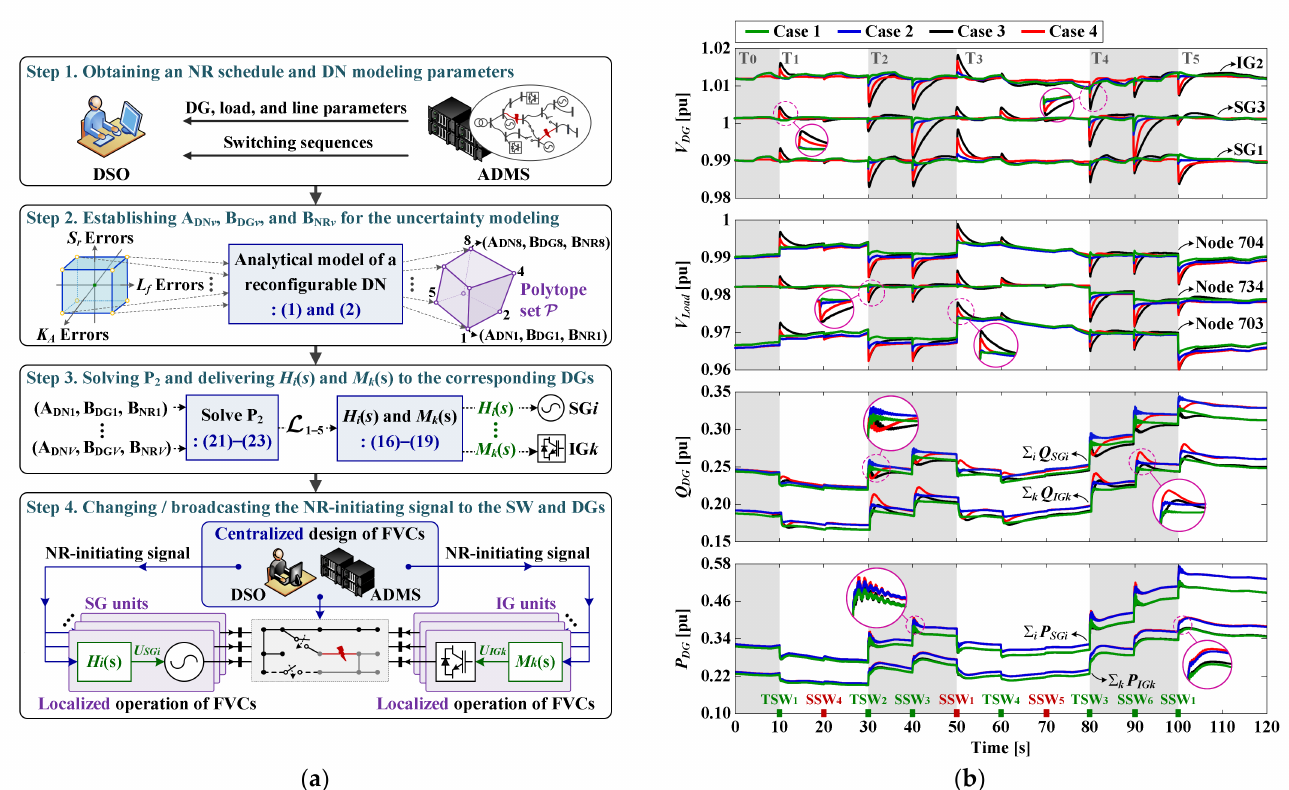
Figure 12. ( a ) A flowchart for implementation of the proposed FVCs and ( b ) comparisons of V DG , V Load , Q DG , and P DG (from top to bottom) between the new proposed VR strategy (Cases 1 and 2) and conventional VR strategies (Cases 3 and 4) for NR-aided load